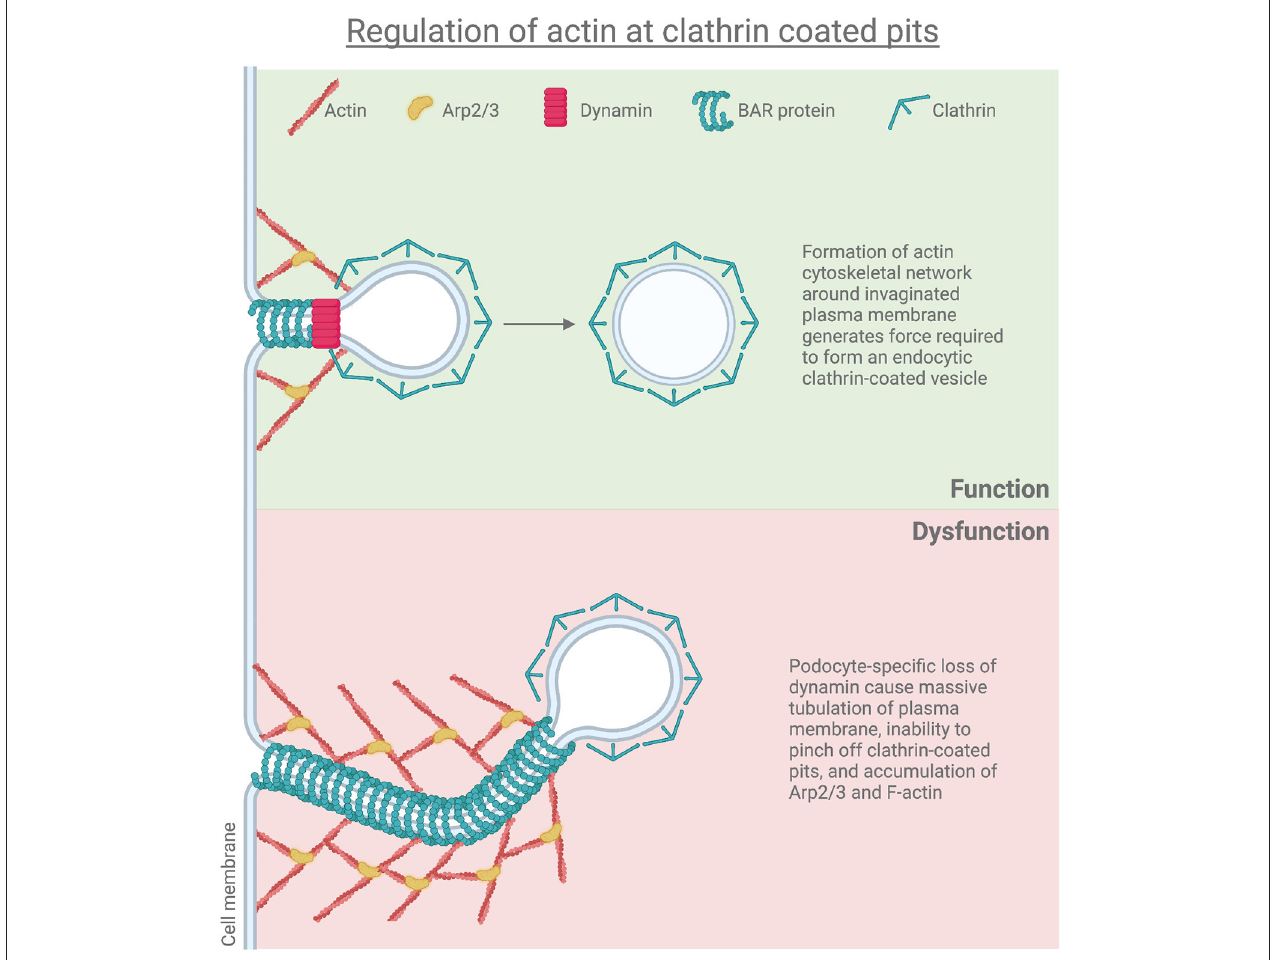
FIGURE 1 | Regulation of actin at clathrin coated